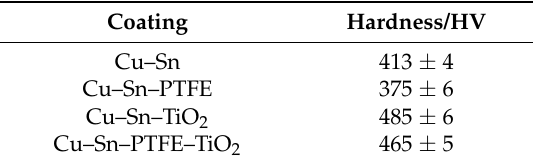
Table 5. Hardness of the coatings.